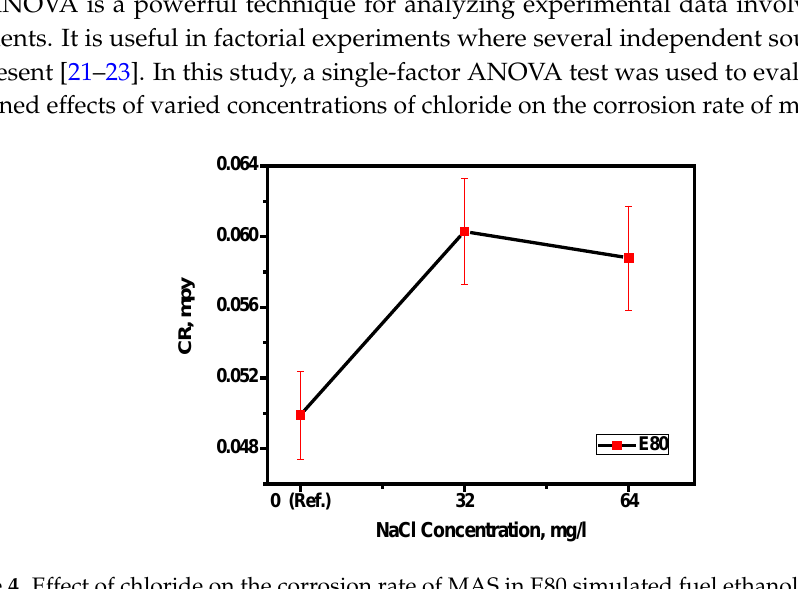
Figure 4. Effect of chloride on the corrosion rate of MAS in E80 simulated fuel ethanol environment. Error bars show standard deviation. Table 4. Analysis-of-variance table for effect of chloride concentration in corrosion rate of MAS.